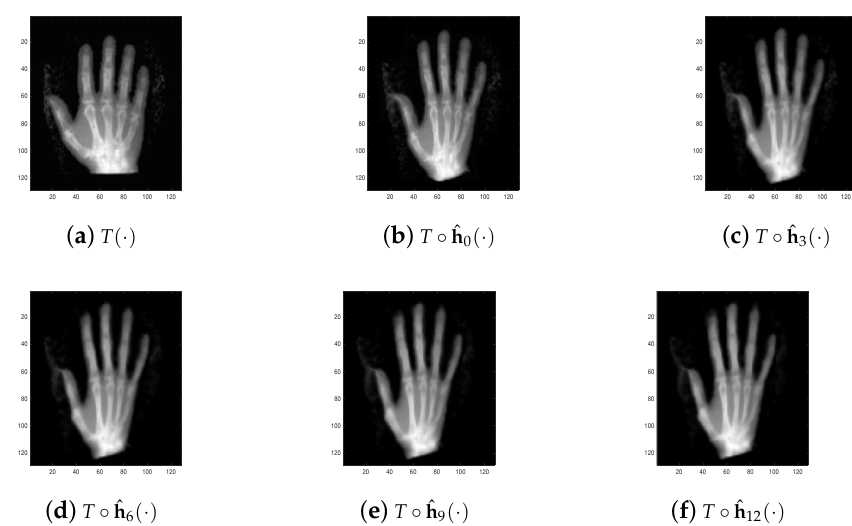
Figure 8. Registration result for different scales on image pairs Hand. ( a ) T ( · ) . ( b ) Re − SSD = 12%. ( c ) Re − SSD = 6.18%. ( d ) Re − SSD = 4.96%. ( e ) Re − SSD = 4.4%. ( f ) Re − SSD = 4.04%.